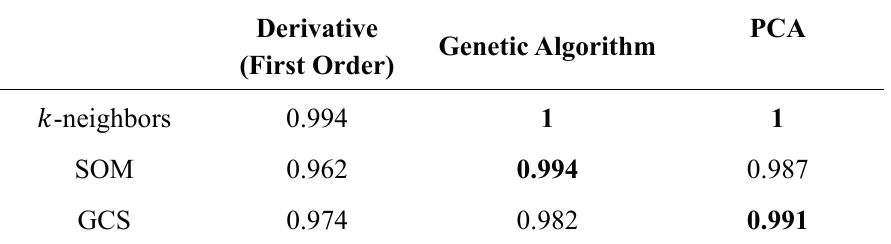
Table 7. Kappa indices obtained with the three classification techniques and the three transformation methods, considering the weighted moving average (WMA) (Gaussian ) as a denoising method and the modified scale based normalization (SBN) window with (cid:2026) (cid:2870) as a normalization